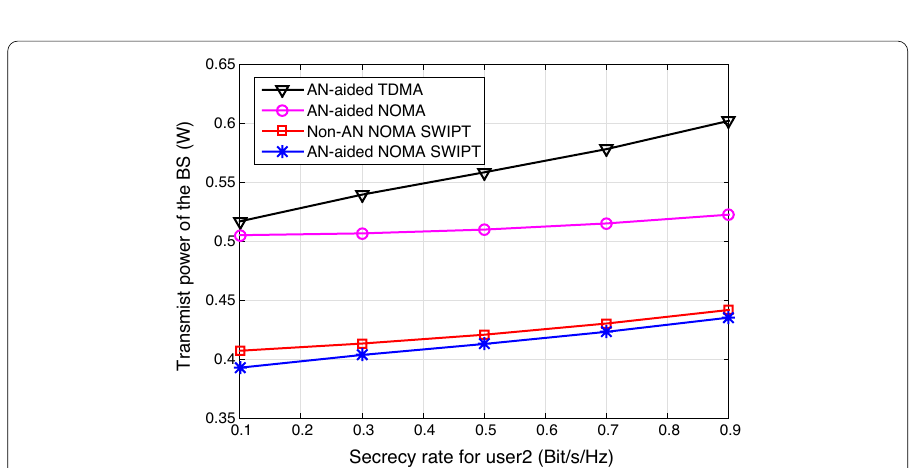
Fig. 6 The minimum transmission power of the BS versus the secrecy rate of user